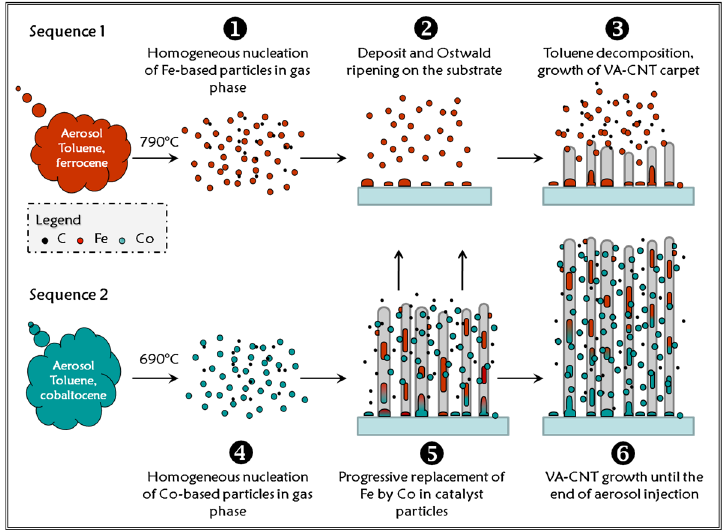
Figure 6. Diagram summarizing CNT carpet growth from sequential injection process including a first sequence using ferrocene followed with a second sequence using cobaltocene.